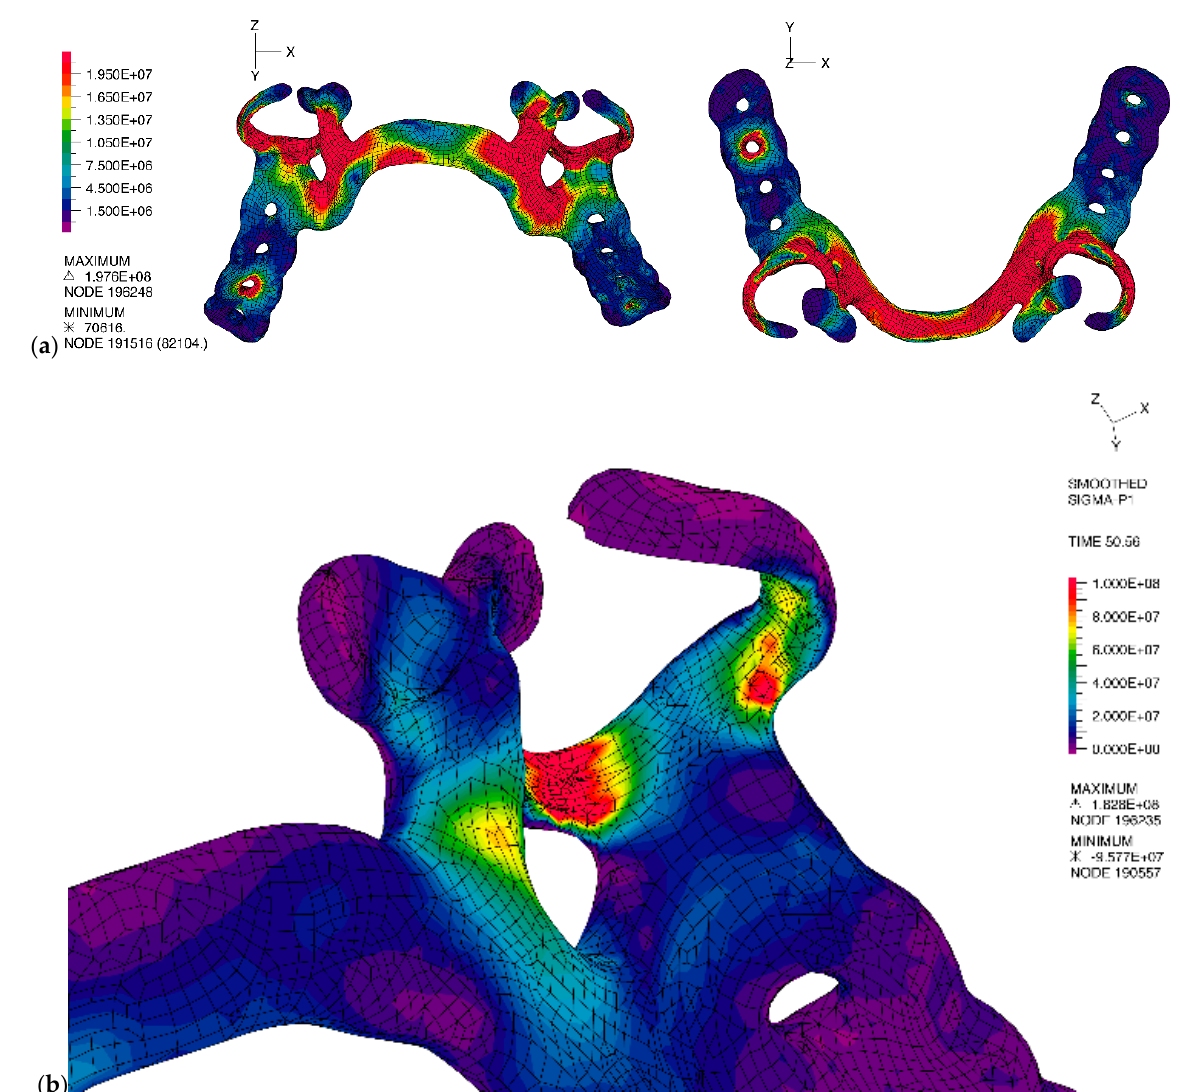
Figure 5. Smoothed stresses distribution on the framework of the CONVENTIONAL RPD model: ( a ) von Mises stress, bottom view on the left, top view on the right; ( b ) principal stresses in the direct retainer, with all non-purple colors representing tensile stresses and the areas in pink with values superior to 100 MPa.